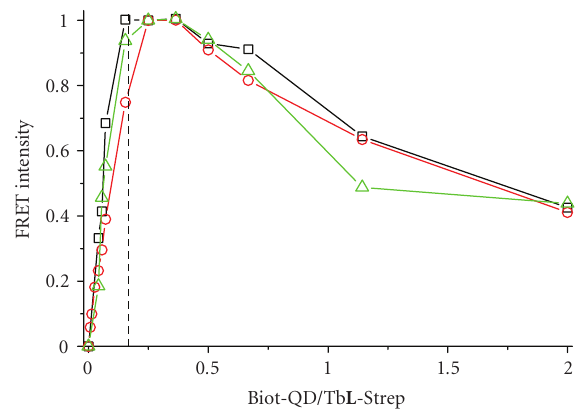
Figure 5: Normalized FRET intensities calculated with (1) and (3) from sensitized QD emission (red circles), short-lived Tb emission due to FRET quenching (black squares), and long-lived Tb emis- sion of unquenched Tb (green triangles). The dotted line indicates a ratio of 6 Tb L -Strep per Biot-QD.